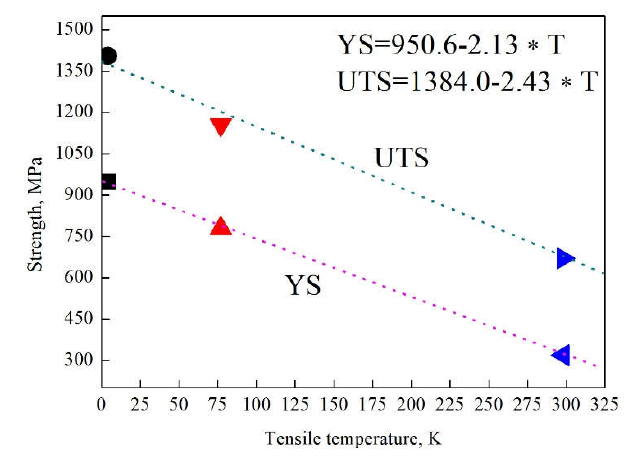
Figure 2. Correlation between strength and deformation temperature. The dark, red and blue colors represent the strengths of the steel deformed at 298, 77 and 4 K, respectively.